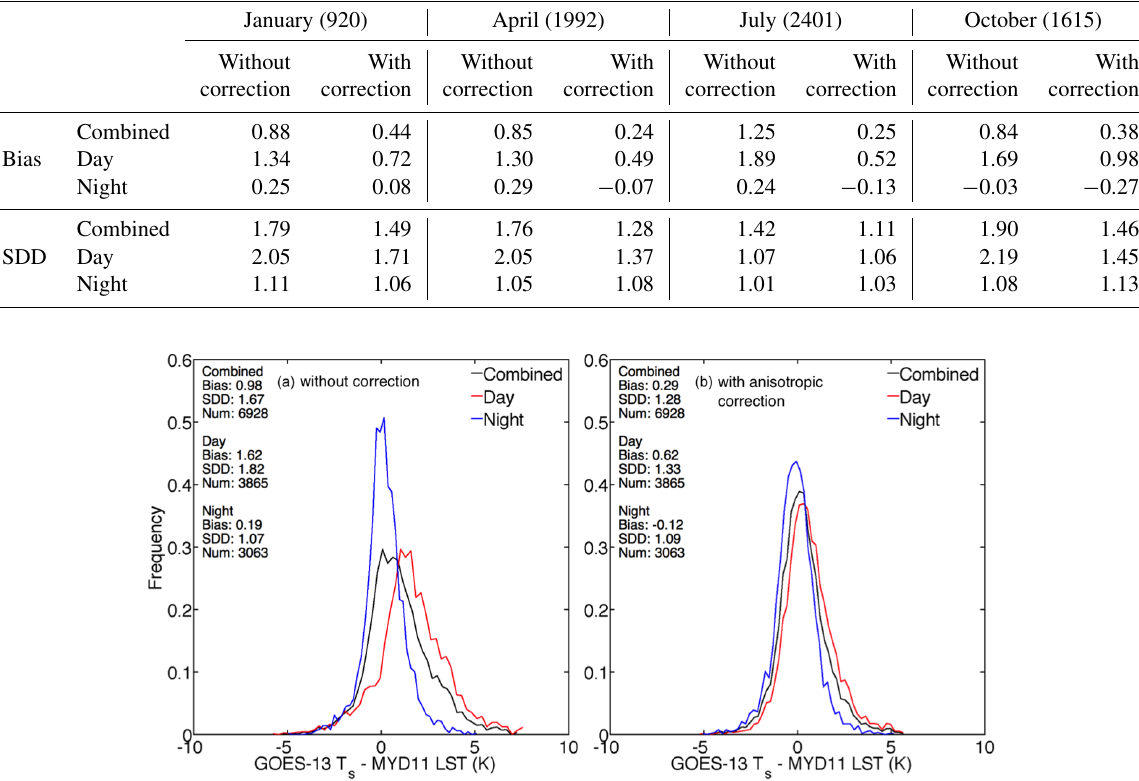
Figure 10. Probability distributions of LST differences from GOES-13 and the MYD11 Aqua MODIS product for day, night, and all times (combined) (a) without and (b) with the Vinnikov et al. (2012) three-kernel anisotropic correction applied, for